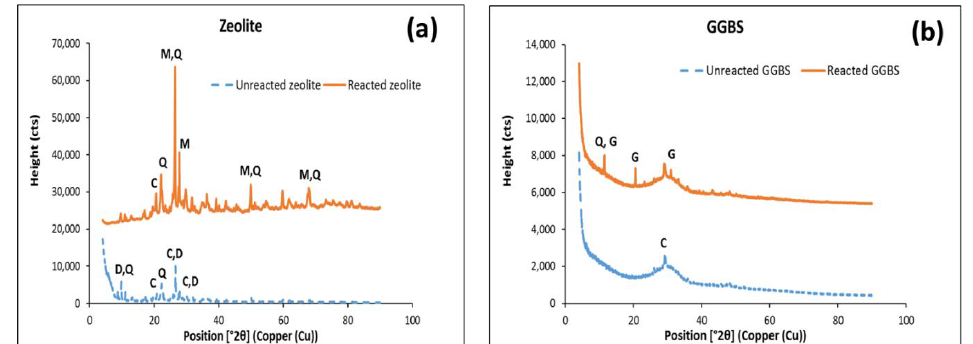
Figure 7. XRD spectra of ( a ) zeolite before and after reaction, ( b ) ground granulated blast-furnace slag (GGBS) before and after reaction with acid mine drainage: C—clinoptilolite; D—mordenite; G—gypsum, H—calcium carbonate/calcium oxide, M—muscovite, Q—quartz.